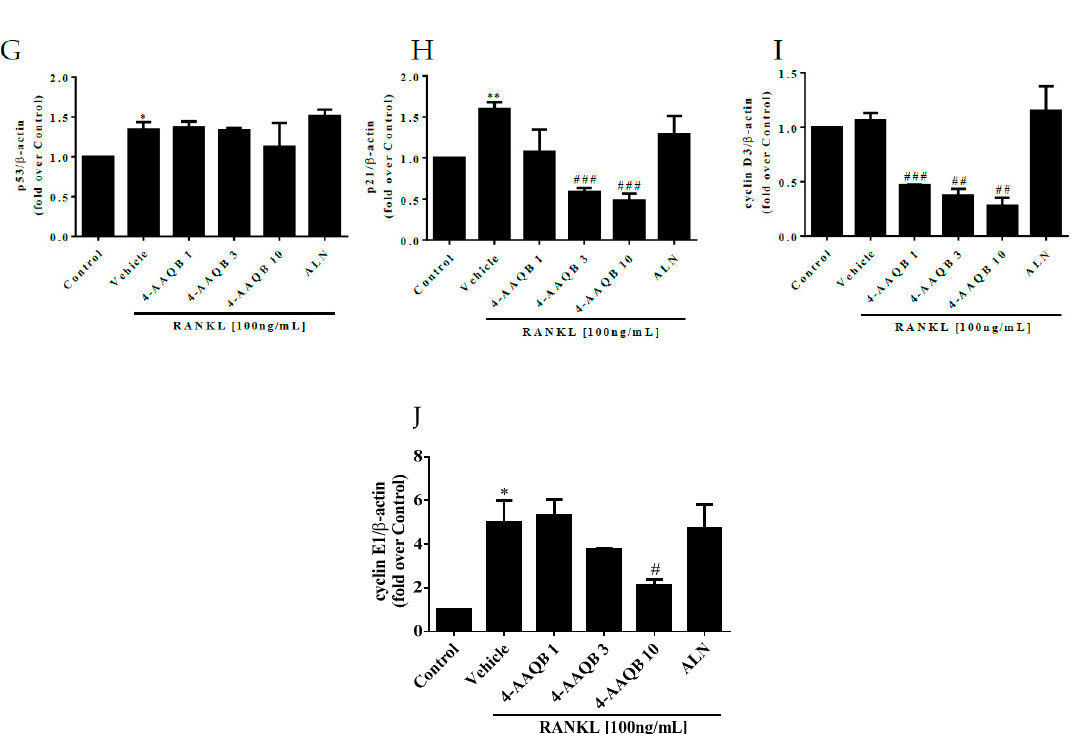
Figure 5. Effects of 4-AAQB on osteoclast apoptosis and the cell cycle after μ Xg stimulation. After exposure to μ Xg ( A ) conditions for 24 h, the cells were treated with 4-AAQB or ALN combined with RANKL for 48 h. Apoptotic proteins were assayed by western blotting. The quantitative results of cleaved PARP ( B ), cleaved caspase-8 ( C ), cleaved caspase-9 ( D ), and cleaved caspase-3 ( E ) represent the mean ± SEM (n = 3). In addition, the cell cycle proteins were also assayed by western blotting ( F ). The quantitative results of p53 ( G ), p21 ( H ), cyclin D3 ( I ), and cyclin E1 ( J ) represent the mean ± SEM (n = 3). * p < 0.05, ** p < 0.01, and *** p < 0.001 versus control; # p < 0.05, ## p < 0.01, and ### p < 0.001 versus RANKL.